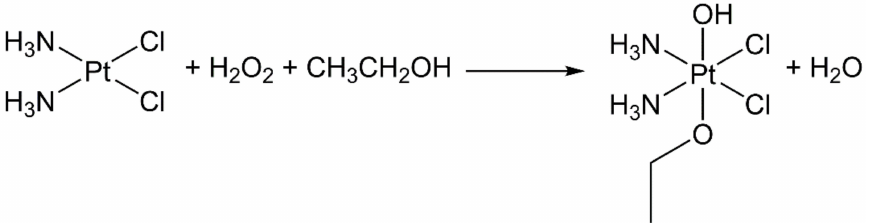
Figure A1. Reaction scheme of the synthesis of ( OC -6-44)-diamminedichloridoethanolatohydroxi